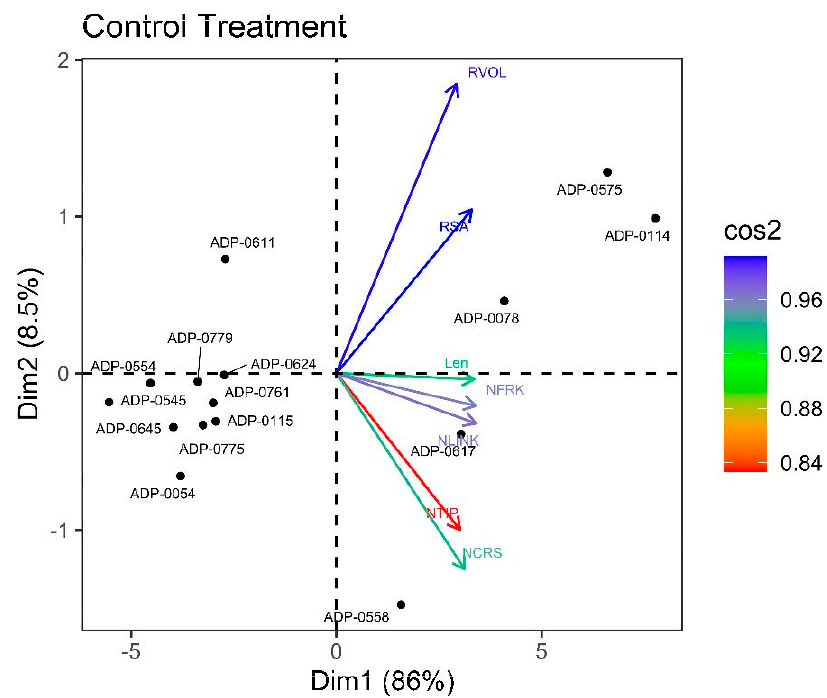
Figure 1. Genotype × trait biplot displaying trait associations across seven root traits of Andean common bean genotypes grown under control treatment of non-stress hydroponics and the top 15 genotypes contributing towards PCA based on Cos 2 Value. Abbreviations as in the previous tables.